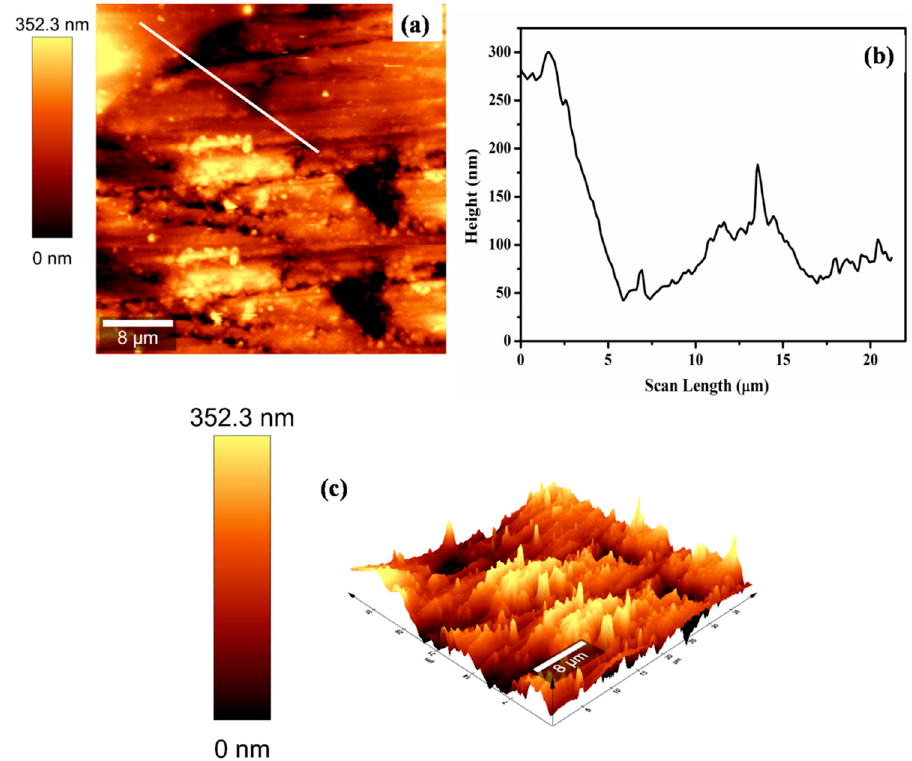
Figure 5. (a , b ) Atomic force microscopy (AFM) topography and cross-sectional profile of composite coating and ( c ) 3-D image of corresponding topography. coating and ( c ) 3-D image of corresponding